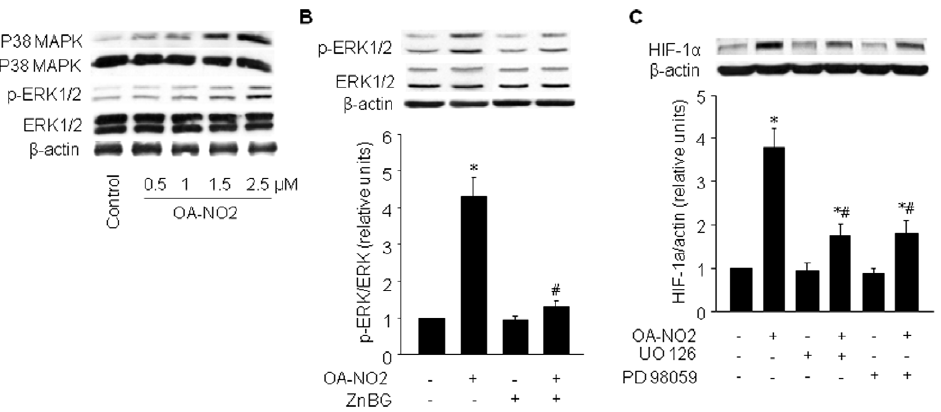
Figure 4. OA-NO 2 -induced HIF-1 a is partially dependent on ERK1/2. A ) BAECs were incubated with the indicated concentrations of OA-NO 2 for 16 h. Protein expression and phosphorylation of p38 MAPK and ERK1/2 were assayed as described in Materials and Methods. The blot is representative of three blots obtained from three independent experiments. B ) BAECs were treated with ZnBG (1 m M) for 30 min followed by incubation with OA-NO 2 for 16 h. ERK1/2 phosphorylation levels were monitored by immunoblot analysis, and band density was normalized to total ERK1/2 levels ( lower panel ). The blot is representative of three blots obtained from three independent experiments. * p , 0.05 vs. control; # p , 0.05 vs. OA-NO 2 group. C ) BAECs were treated with OA-NO 2 alone or with the ERK1/2 signaling inhibitors, UO126 (10 m M) or PD98059 (50 m M), 1 h before the addition of OA-NO 2 . HIF-1 a protein levels were monitored by immunoblot analysis, and band density was normalized to b -actin levels ( lower panel ). The blot is representative of three blots obtained from three independent experiments. * p , 0.05 vs. control; # p , 0.05 vs. OA-NO 2